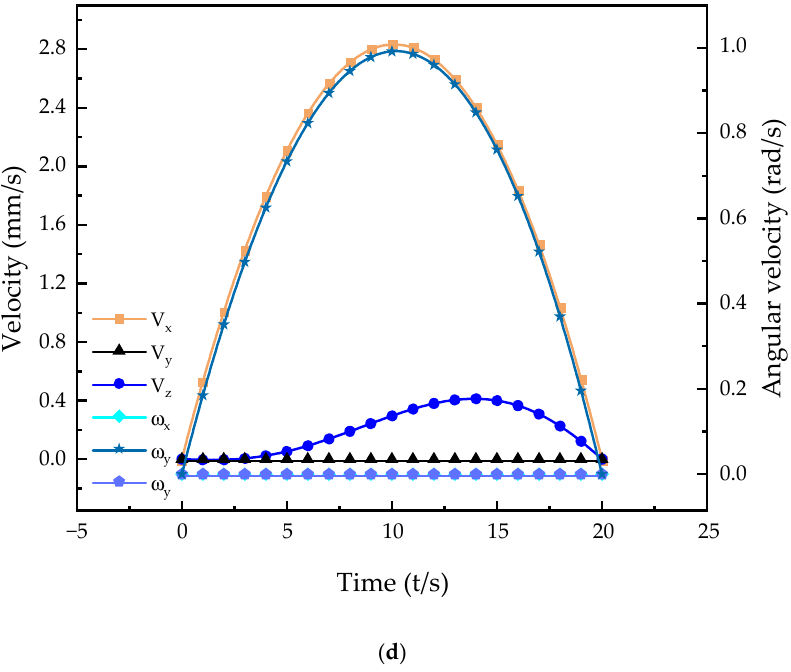
Figure 6. Variations in the velocity and angular velocity of the moving platform y for a single movement.( a ) Variations in the velocity and angular velocity of flexion motion. ( b ) Variations in the velocity and angular velocity of the extension motion. ( c ) Variations in the velocity and angular velocity of abduction motion. ( d ) Variations in the velocity and angular velocity of adduction motion.